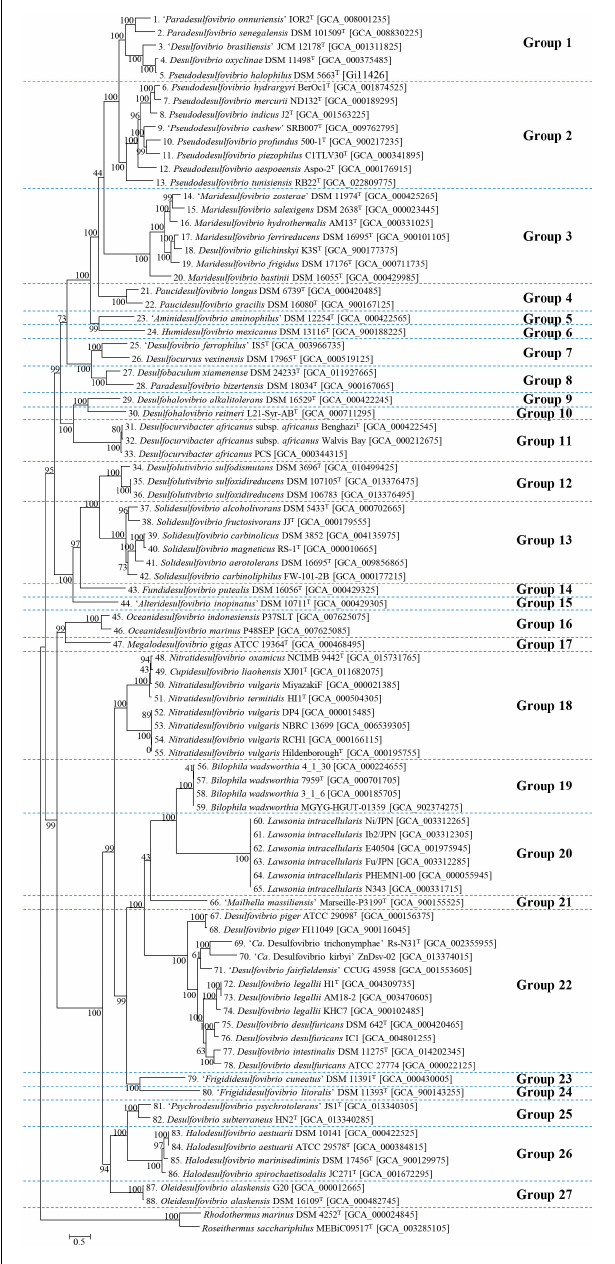
FIGURE 1 | Phylogenomic tree of strains belonging to Desulfovibrionacae. Using 400 core gene markers, 88 Desulfovibrionaceae family strains were subdivided into 27 groups. Two type strains belonging to Rhodothermaceae were selected as outgroups. Each number before the scientific name implies the identical organism with the corresponding number at the subsequent analysis. The scale bar represents 5% estimated sequence